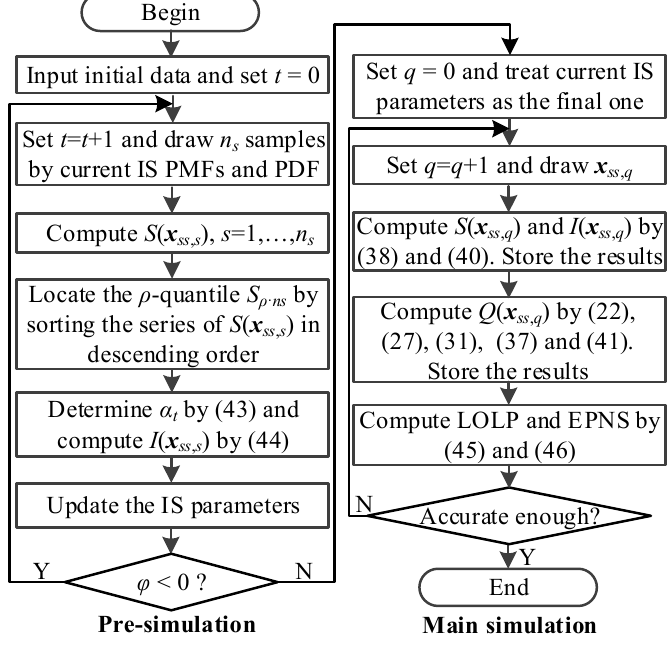
Figure 2. Flowchart of the DRCE-IS method.